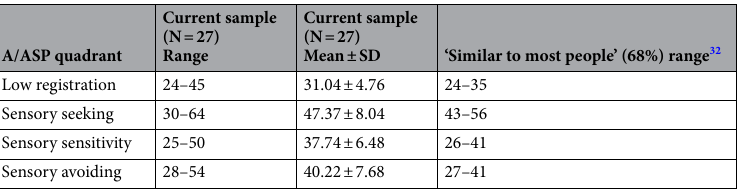
Table 1. Adolescent/Adult Sensory Profile (A/ASP) quadrant scores: comparison with the normative